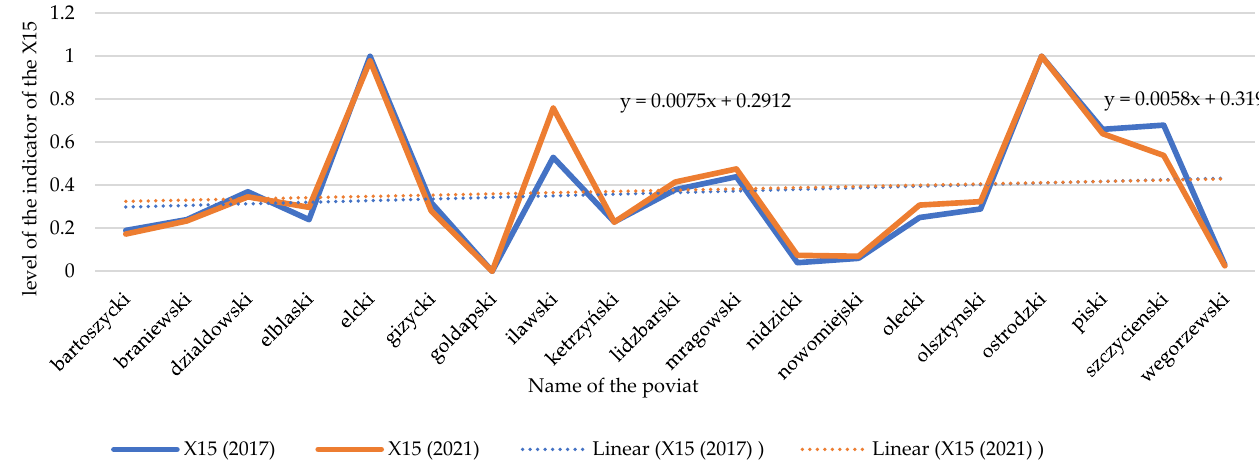
Figure 5. Temporal dynamics of green energy production (X15). Source: own study.